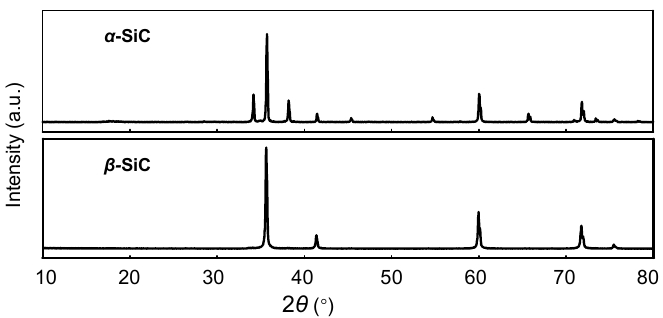
Figure 2. X-ray di ff raction results of the SiC particles. Figure 2. X-ray diffraction results of the SiC particles. Figure 2. X-ray diffraction results of the SiC particles.